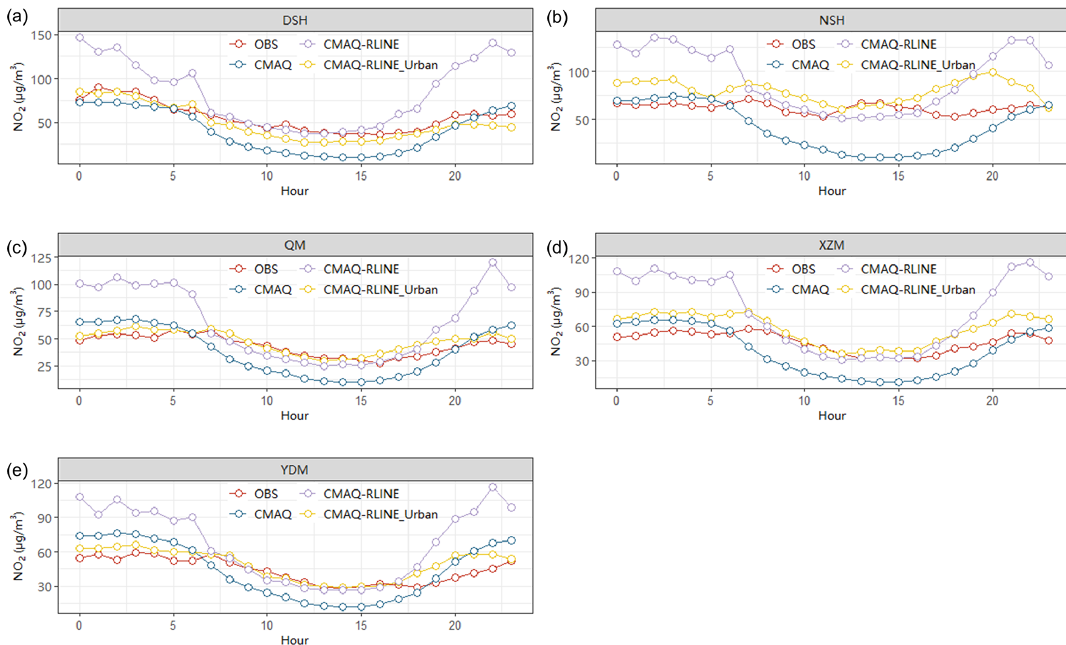
Figure 9. Diurnal variations in observed and predicted hourly averaged NO 2 concentrations from different models at near-road monitoring sites: (a) DSH; (b) NSH; (c) QM; (d) XZM; (e)